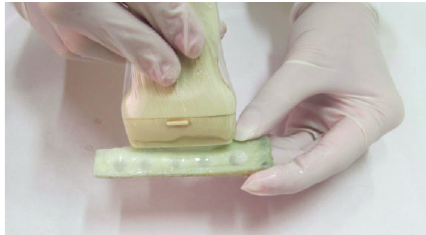
Figure 5: Ultrasonic gel was applied on the intact surface on the linear ultrasonic probe that was placed on the